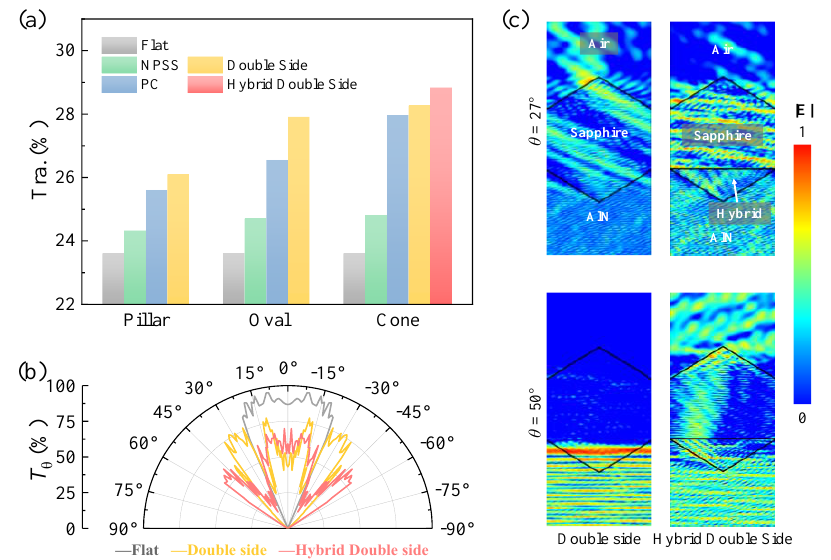
Figure 8. ( a ) A summary of Tra. distributions for the three related cases with the different configurations. ( b ) Incident angle-dependent Tra. of the three representative cases. ( c ) Normalized distributions of electric-field intensities for the two related structures under θ = 27° and 50°.